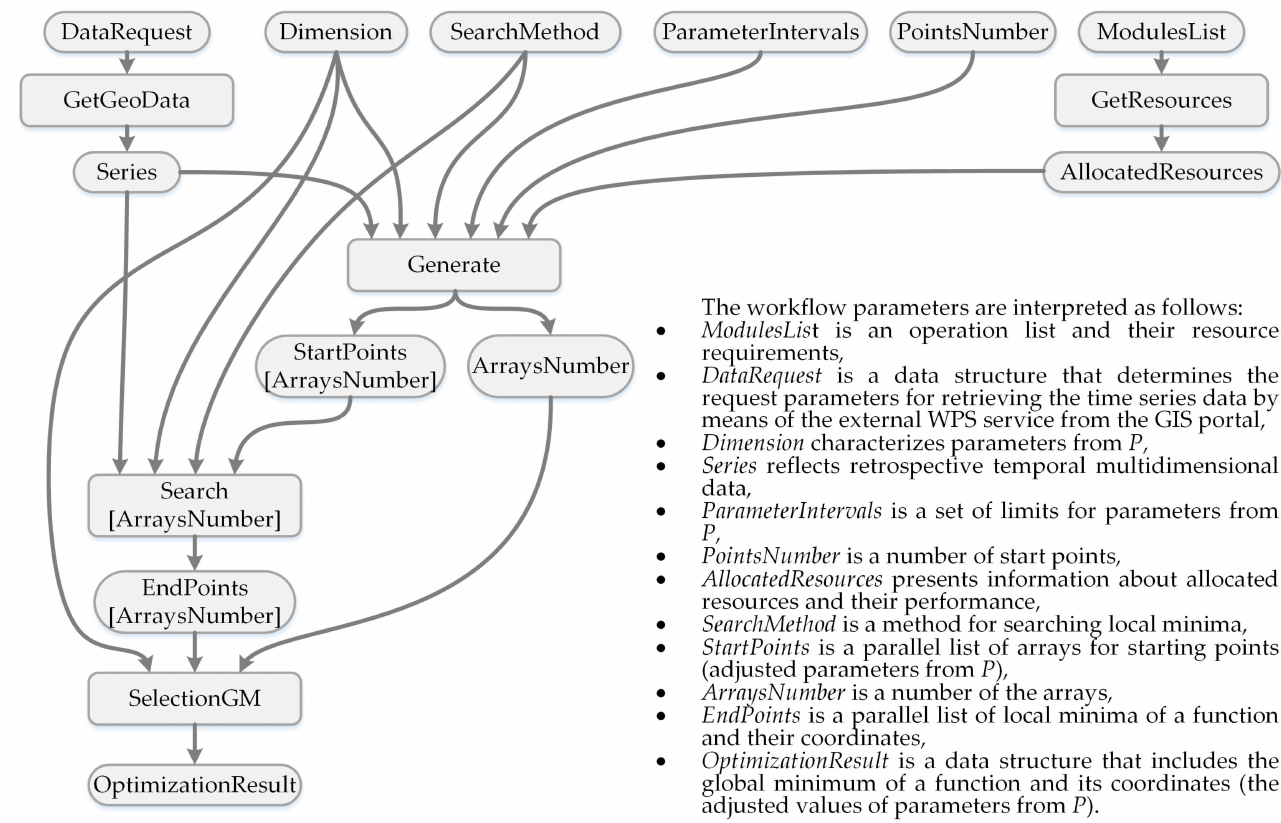
Figure 4. Workflow for adjusting values of parameters from P